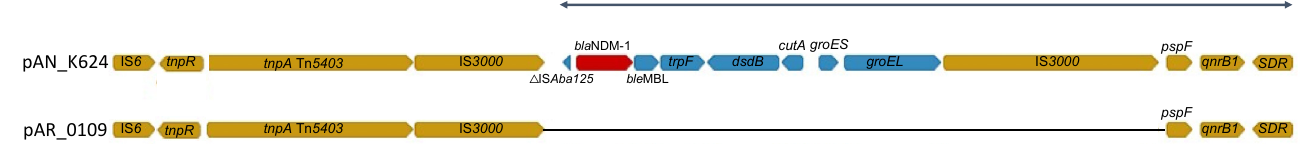
backbone is is shown.